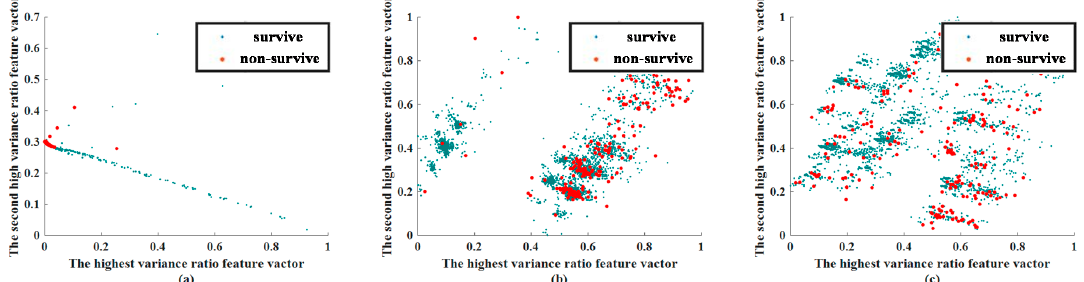
Figure 5. Extracted feature visualization of mortality prediction for the testing dataset in 28 d: ( a ) CNN, ( b ) AE, ( c ) PCA. Abbreviation: PCA, principal component analysis; AE, autoencoder; CNN, convolutional neural network.